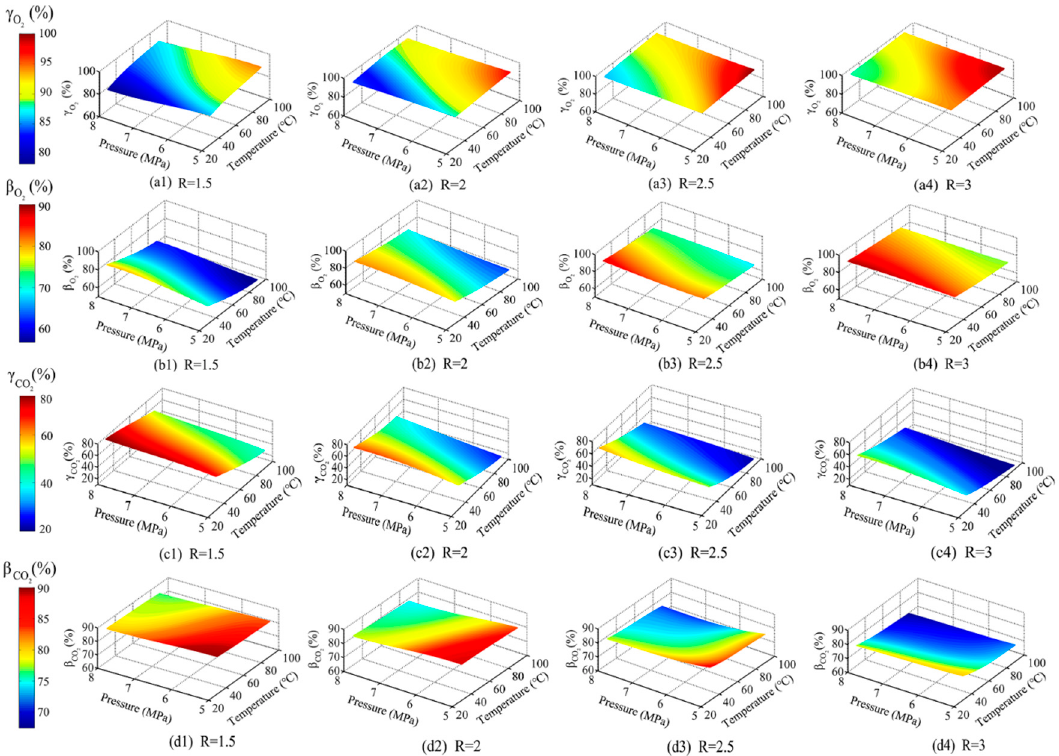
Figure 6. The effect of R on the performance of the high-pressure and low-pressure separators, ( a1 ) γ O2 at R = 1.5, ( a2 ) γ O2 at R = 2, ( a3 ) γ O2 at R = 2.5, ( a4 ) γ O2 at R = 3, ( b1 ) β O2 at R = 1.5, ( b2 ) β O2 at R = 2, ( b3 ) β O2 at R = 2.5, ( b4 ) β O2 at R = 3, ( c1 ) γ CO2 at R = 1.5, ( c2 ) γ CO2 at R = 2, ( c3 ) γ CO2 at R = 2.5, ( c4 ) γ CO2 at R = 3, ( d1 ) β CO2 at R = 1.5, ( d2 ) β CO2 at R = 2, ( d3 ) β CO2 at R = 2.5, and ( d4 ) β CO2 at R = 3.